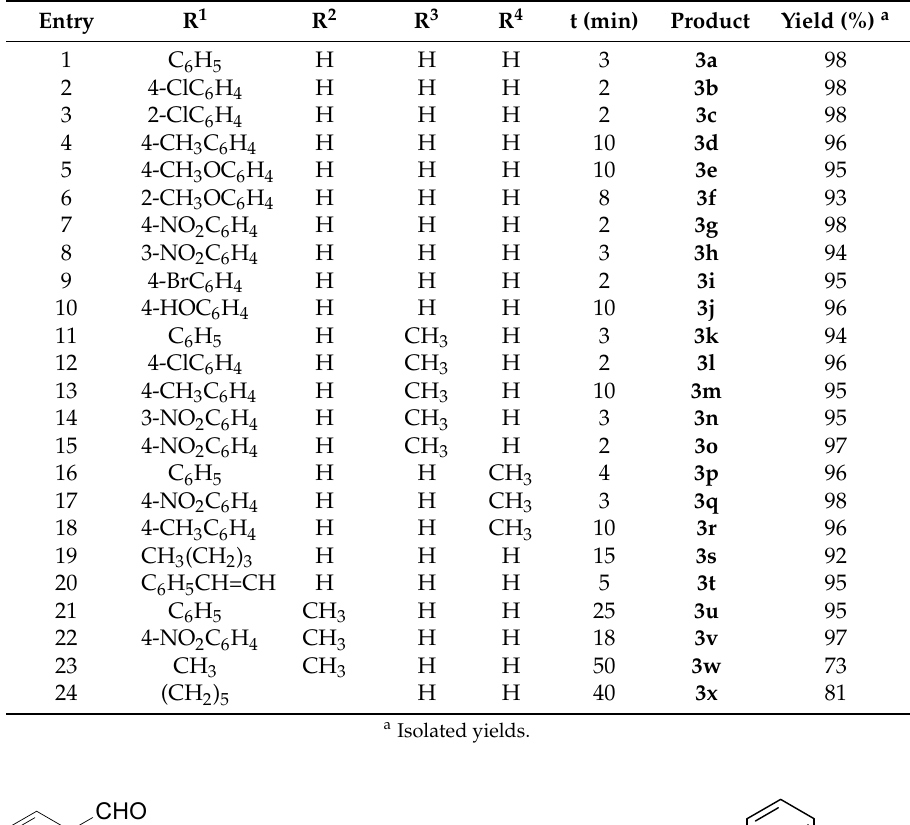
Table 2. PEG 1000 -DAIL-catalyzed synthesis of bis(indolyl)methanes ( 3a – 3x ).